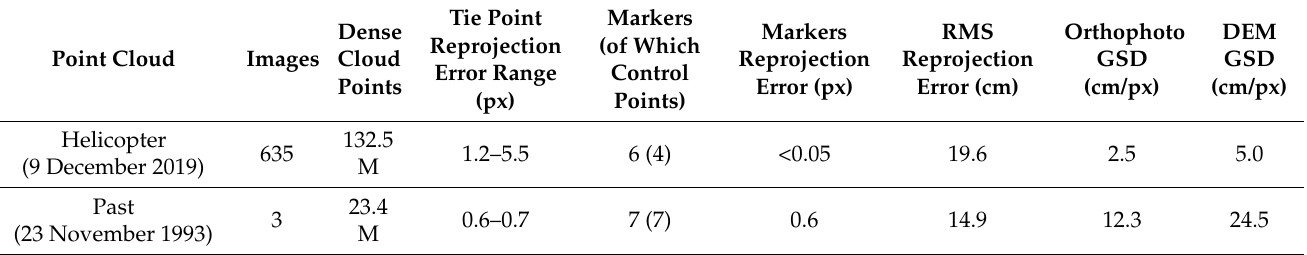
Table 1. Point cloud characteristics of the two aerial